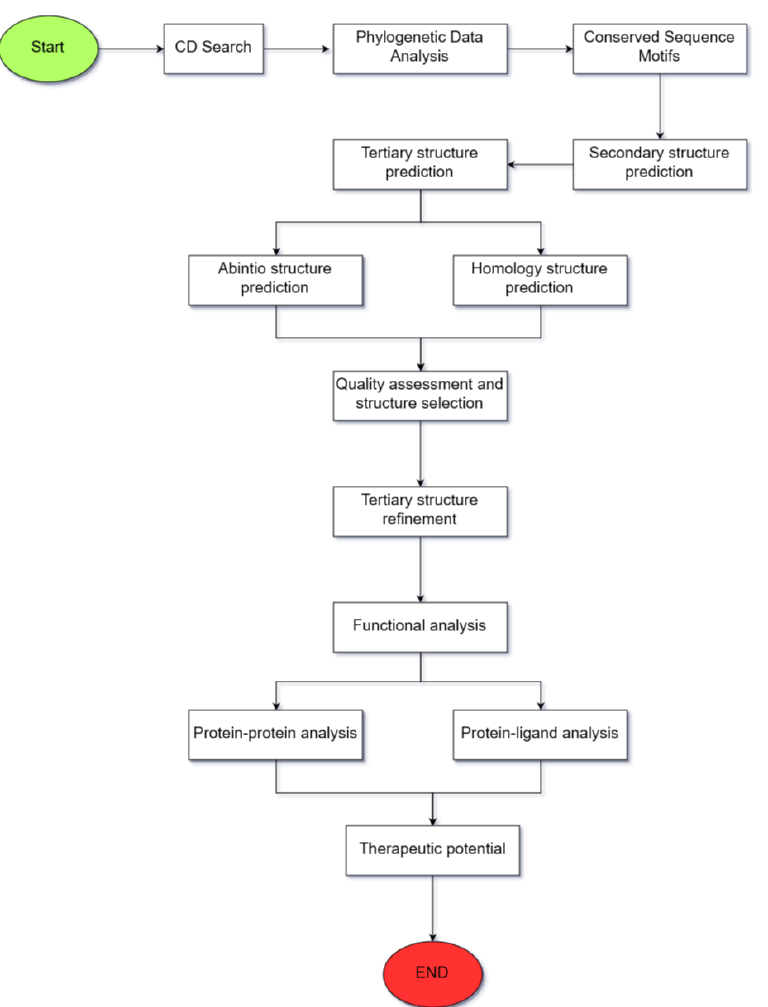
Figure 1. A graphical representation of the proposed methodology summarizing the sequence of steps that should be